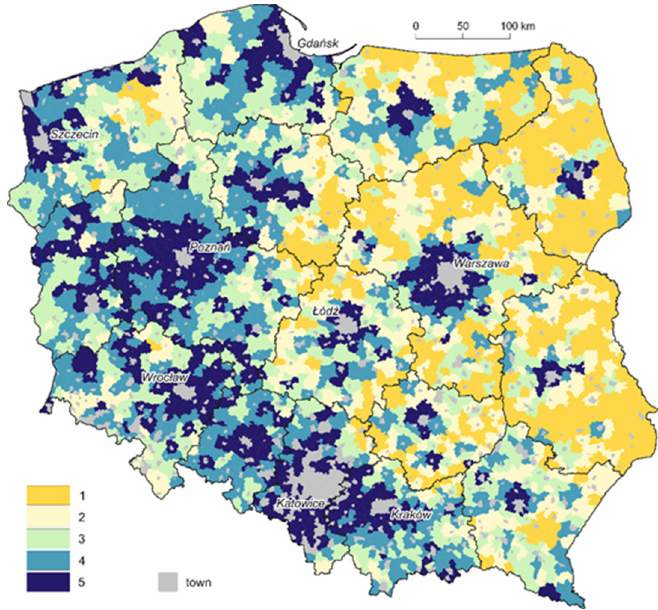
Figure 5. Level of social and economic development of rural areas in Poland. Source: Copyright by